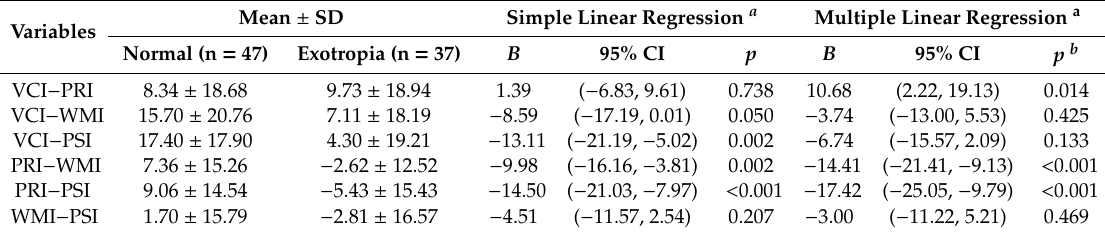
Table 3. Comparison of subtest-level discrepancy between the exotropia group and the normal group. Mean ± SD Simple Linear Regression Variables